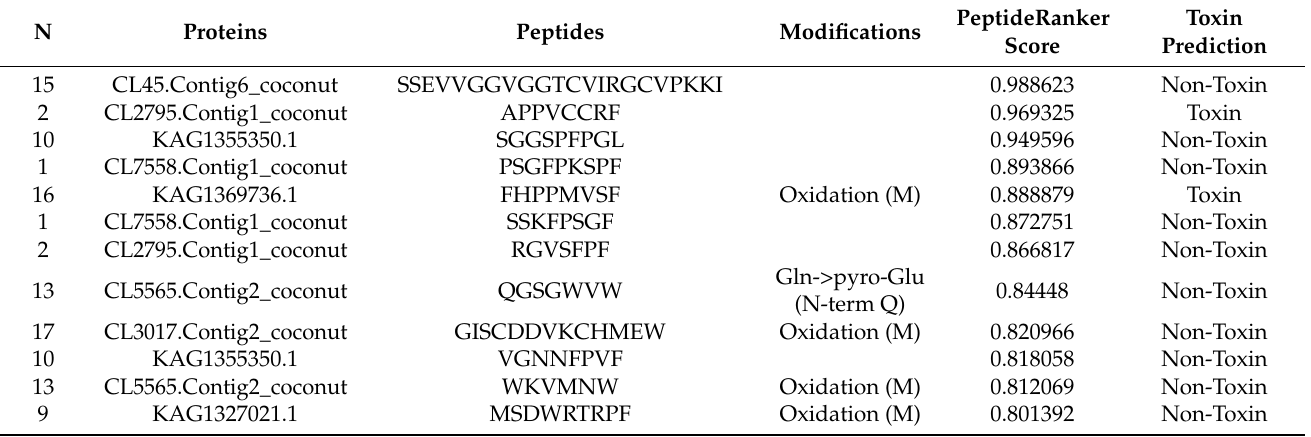
Table 5. Selected potential bioactive peptides of the antioxidant proteins predicted by in-silico digestions with